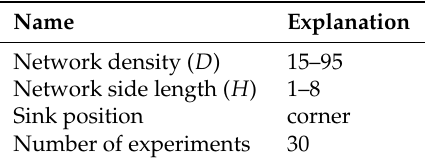
Table 2. Simulation